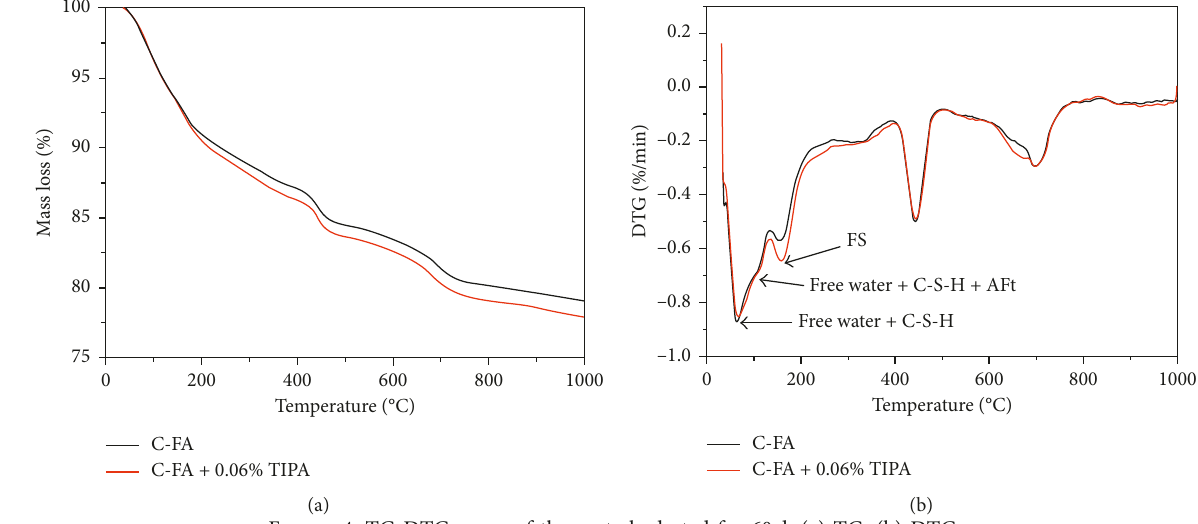
Figure 4: TG-DTG curve of the paste hydrated for 60d. (a) TG; (b)